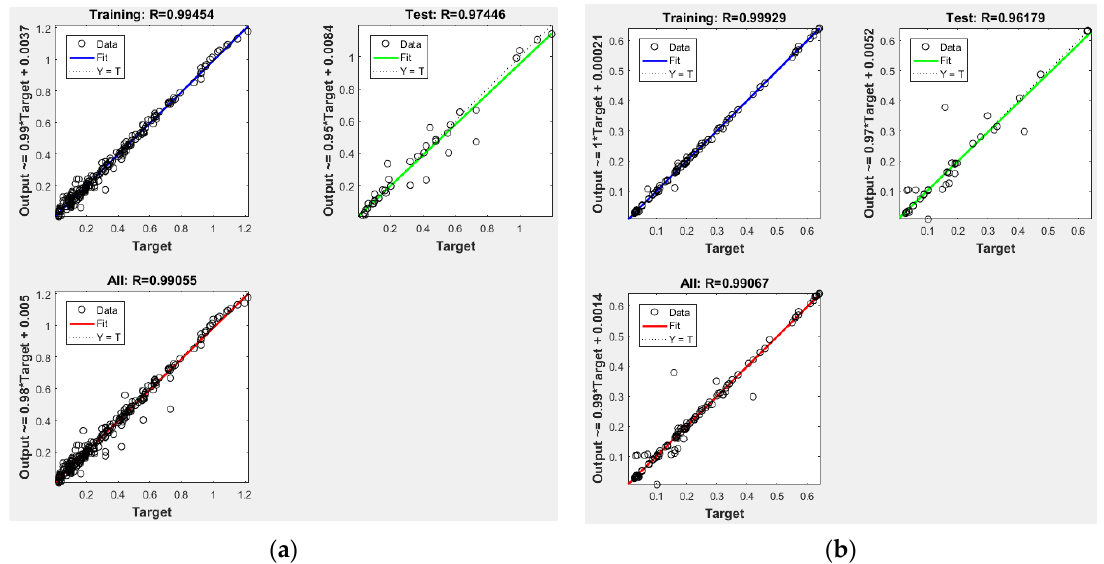
Figure 2. ( a ) Model 1 training and testing results; ( b ) Model 2 training and testing results (both from MATLAB ® Neural Fitting Tool).